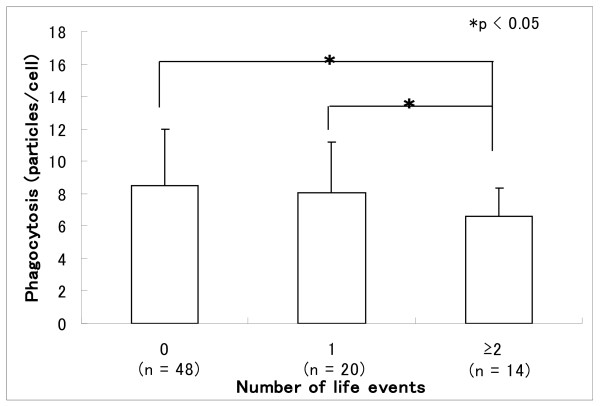
Relationship between number of life events over the past 18 months and phagocytosis by neutrophils among elderly men.